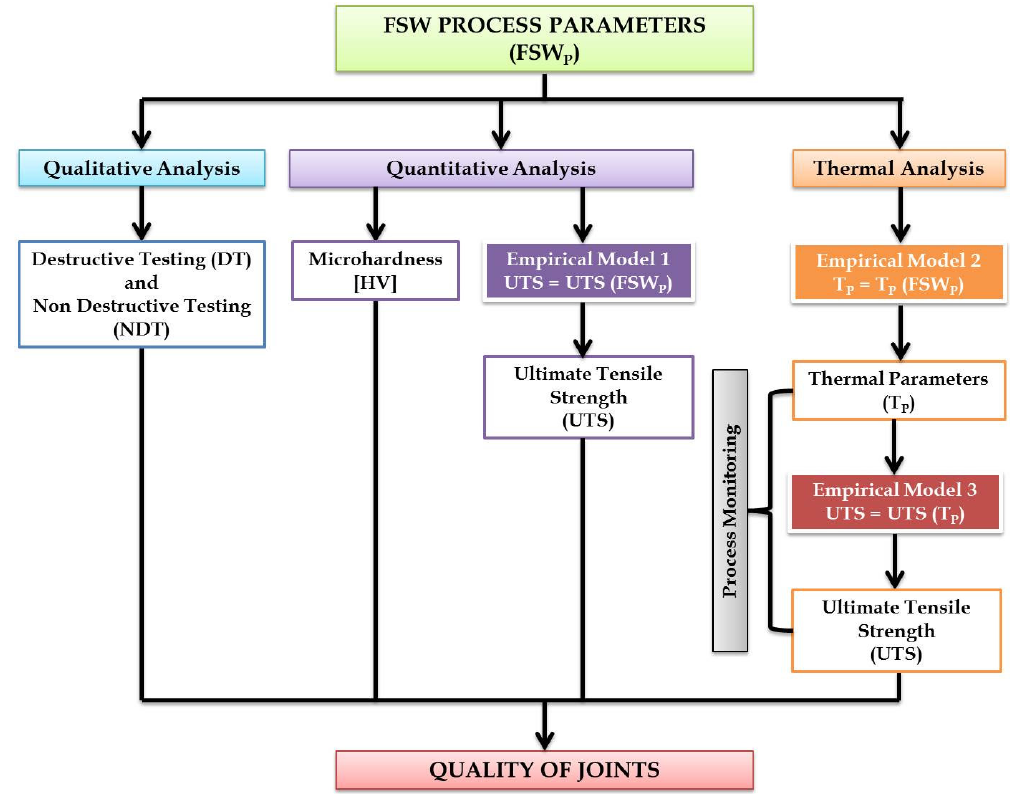
Figure 1. Empirical models used for evaluating the quality of FSW process by means of destructive and non ‐ destructive tests.